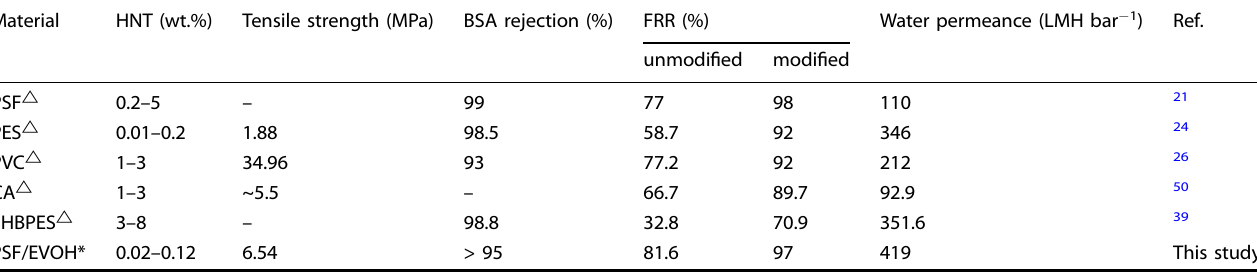
Table 2. A review of the literature on the effect of HNT nanoparticles on morphology, properties, and performance of MMM.